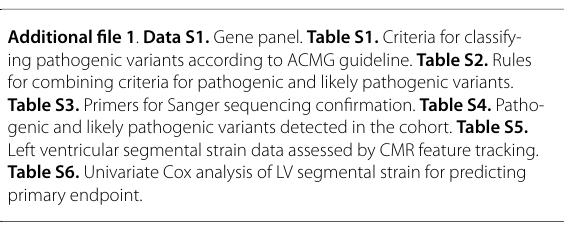
Table S6. Univariate Cox analysis of LV segmental strain for predicting primary